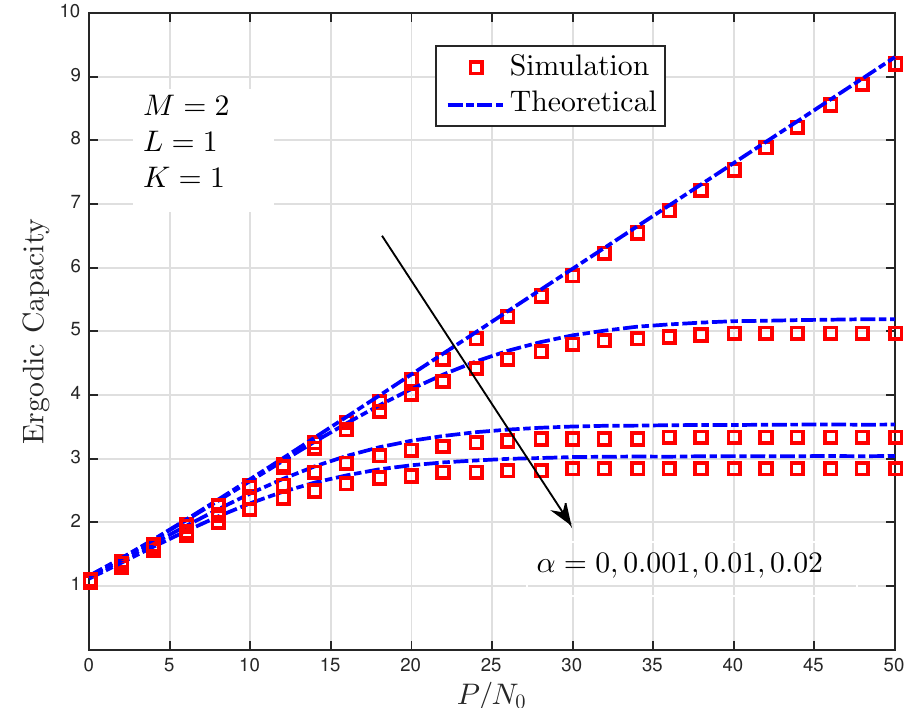
Figure 6. Ergodic capacity performance of the secondary network versus P / N 0 for various interference leakage